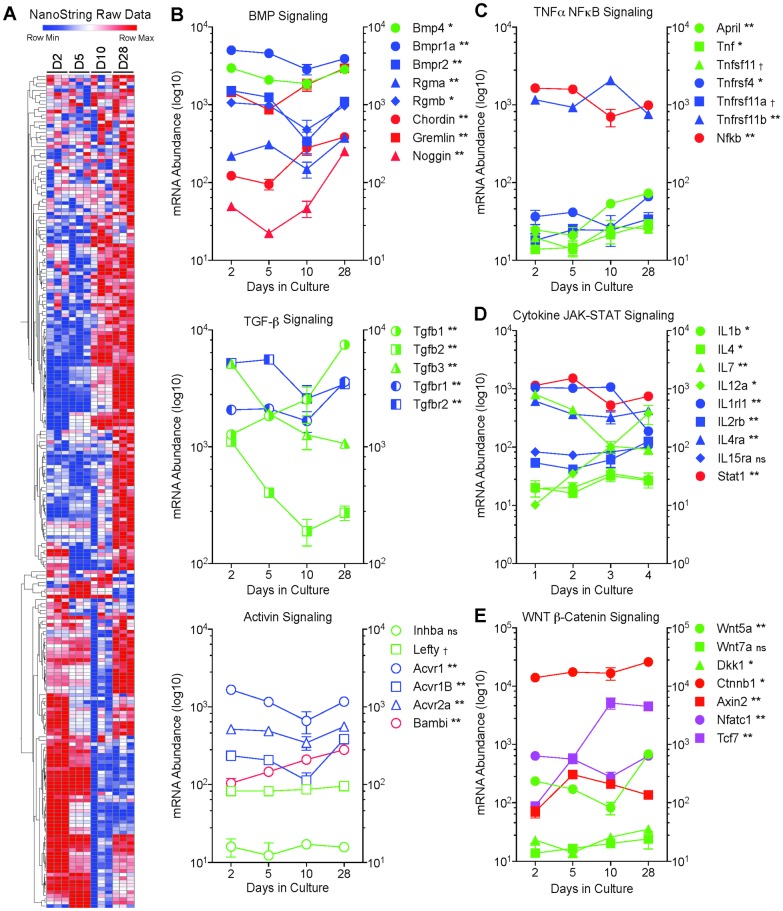
NanoString analysis of bone-related mRNAs during MC3T3-E1 cell differentiation.Total RNA was isolated from three independent cultures of MC3T3-E1 cells at days 2, 5, 10 and 28, and mRNA abundance quantified by NanoString nCounter using a bone specific Code Set (S1 Table). A. Heat map depicting changes in mRNA abundance for individual mRNA species (rows) over time in culture (columns) for day 2 (D2), day 5 (D5), day 10 (D10), and day 28 (D28). Expression data, after log2 adjustment, were subjected to Euclidean heirarchical clustering in Morpheus to group genes based on similarity in temporal change. mRNA abundance of selected ligands, receptors, modulators, and mediators related to BMP/TGFβ/Activin (B), TNFα/NFκB (C), IL/JAK-STAT (D), and WNT/β-catenin (E) signaling. BMP pathway components shown are: BMP 4 (Bmp4); BMP receptor 1A (Bmpr1a); BMP receptor 2 (Bmpr2); the BMP co-receptors, repulsive guidance molecule (RGM) A (Rgma) and RGM B (Rgmb); the BMP negative regulators, Chordin and Noggin; and the DAN family BMP antagonist, Gremlin. TGFβ pathway components shown are: TGFβ1 (Tgfb1); TGFβ2 (Tgfb2); TGFβ3 (Tgfb3); TGFβ receptor 1 (Tgfbr1); and TGFβ receptor 2 (Tgfbr2). Activin pathway components shown are: inhibin subunit βA (Inhba); activin A receptor type 1 (Acvr1); activin A receptor type 1B (Acvr1b); activin A receptor type 2A (Acvr2a); BMP and activin membrane bound inhibitor (Bambi); and the activin and TGFβ receptor ligand, left-right determination factor 1 (Lefty). TNFα pathway components shown are: TNF ligand superfamily member 13-like (April); TNF (Tnf); RANKL (Tnfsf11); TNF-receptor superfamily member 4 (Tnfrsf4); receptor activator of NFκB (Tnfrsf11a); TNF receptor superfamily member 11b (Tnfrsf11b); and NFκB (Nfkb). Interleukin pathway components shown are: IL1B (Il1b); IL4 (Il4); IL7 (Il7); IL12A (Il12a); IL1 receptor-like 1 (Il1rl1); IL2 receptor β subunit (Il2rb); IL4 receptor α subunit (Il4ra); IL15 receptor α subunit (Il15ra); and STAT1 (Stat1). WNT pathway components shown are: WNT 5A (Wnt5a); Wnt 7A (Wnt7a); the WNT signaling pathway inhibitor, Dickkopf (Dkk1); β-catenin (Ctnnb1); the regulator of β-catenin stability, Axin 2 (Axin2); and the β-catenin regulated transcription factors, nuclear factor of activated T cells 1 (Nfatc1) and transcription factor 7 (Tcf7). In each graph, symbols representing ligands are shown in green, receptor subunits in blue, intracellular mediators and modulators in red, and transcription factors in lavender. Data shown represent the Mean ± SD of triplicate samples. Error bars not shown are smaller than the symbol. † P<0.05; * P<0.01; ** P<0.001 different in abundance between at least two time points by two-way ANOVA with Tukey’s multiple comparisons test; ns, not significant.